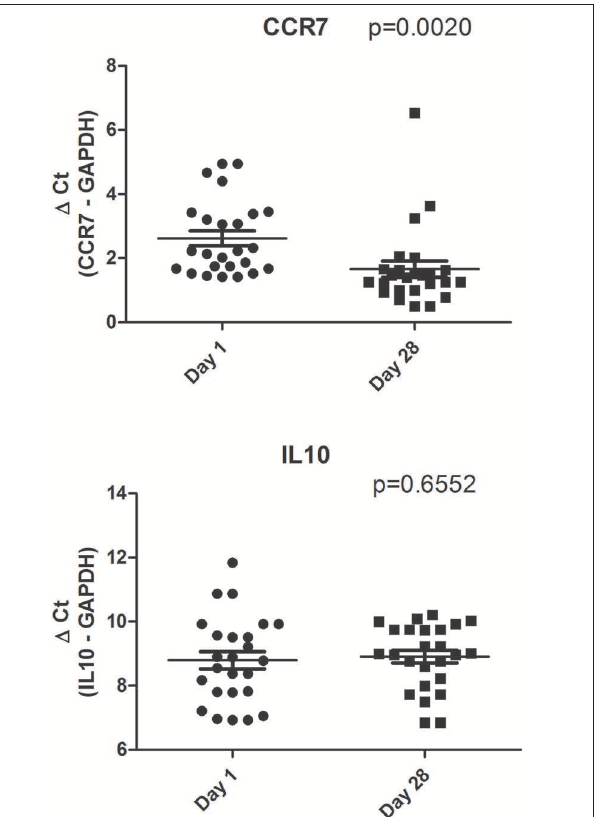
FIGURE 2 | CCR7 and IL10 transcriptional levels in the venous blood of group treated with L Reuteri DSM 17938. Data are represented as circle plots (day 1) and box plots (day 28), with horizontal lines depicting the averages. Relative messenger RNA levels were analyzed by real-time PCR and represented by 1 Ct. The Paired t -test was performed.